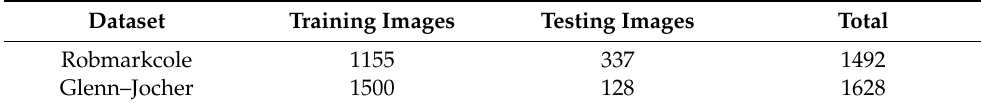
Table 2. Distribution of fire images in the dataset.